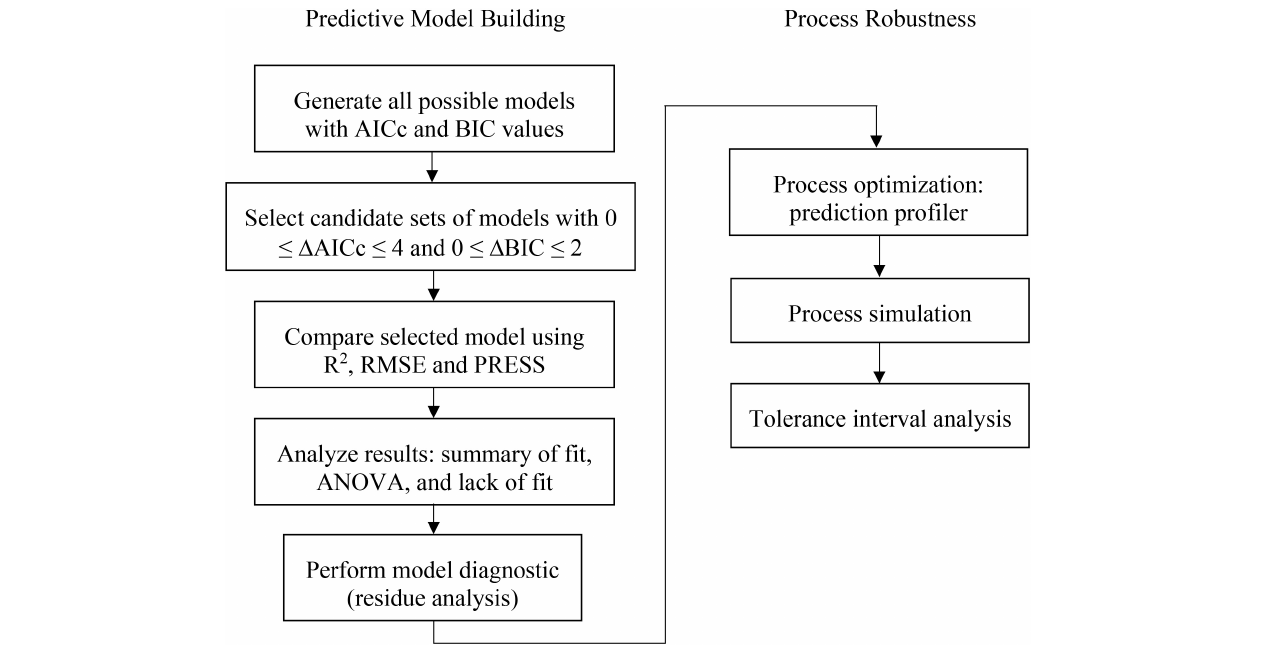
FIGURE 1 | Predictive model building and process robustness